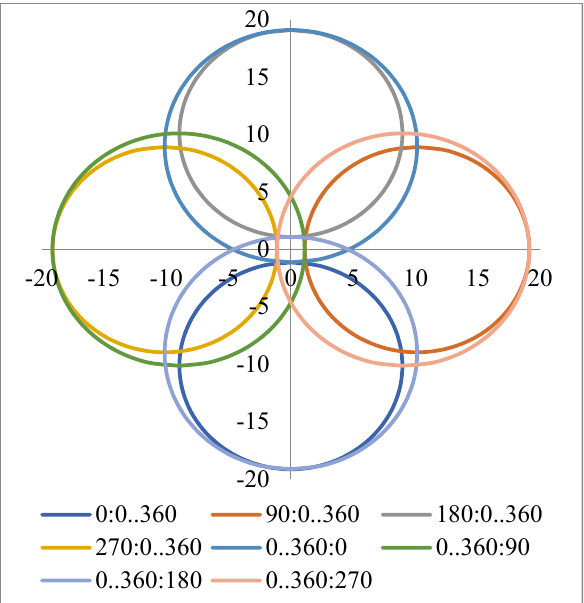
Figure 3. Circles obtained in the scanned plane when one of the prisms is fixed (positioned in four successive positions, at 0°, 90°, 180°, and 270°) and the other one is mobile. The four larger circles correspond to the situation when Prism 1 (positioned further away from the screen than Prism 2) is mobile. The values on the axes are in millimeters. The first number represents the rotational angle of Prism 1 and the second that of Prism 2, for example 0:0…360 means that Prism 1 is fixed (in the 0° position) and that Prism 2 rotates from 0 to 360°; 0…360:90 means that Prism 1 performs a full rotation while Prism 2 is fixed at 90° from its 𝜑 = 0 ) position in Figure 2d1.